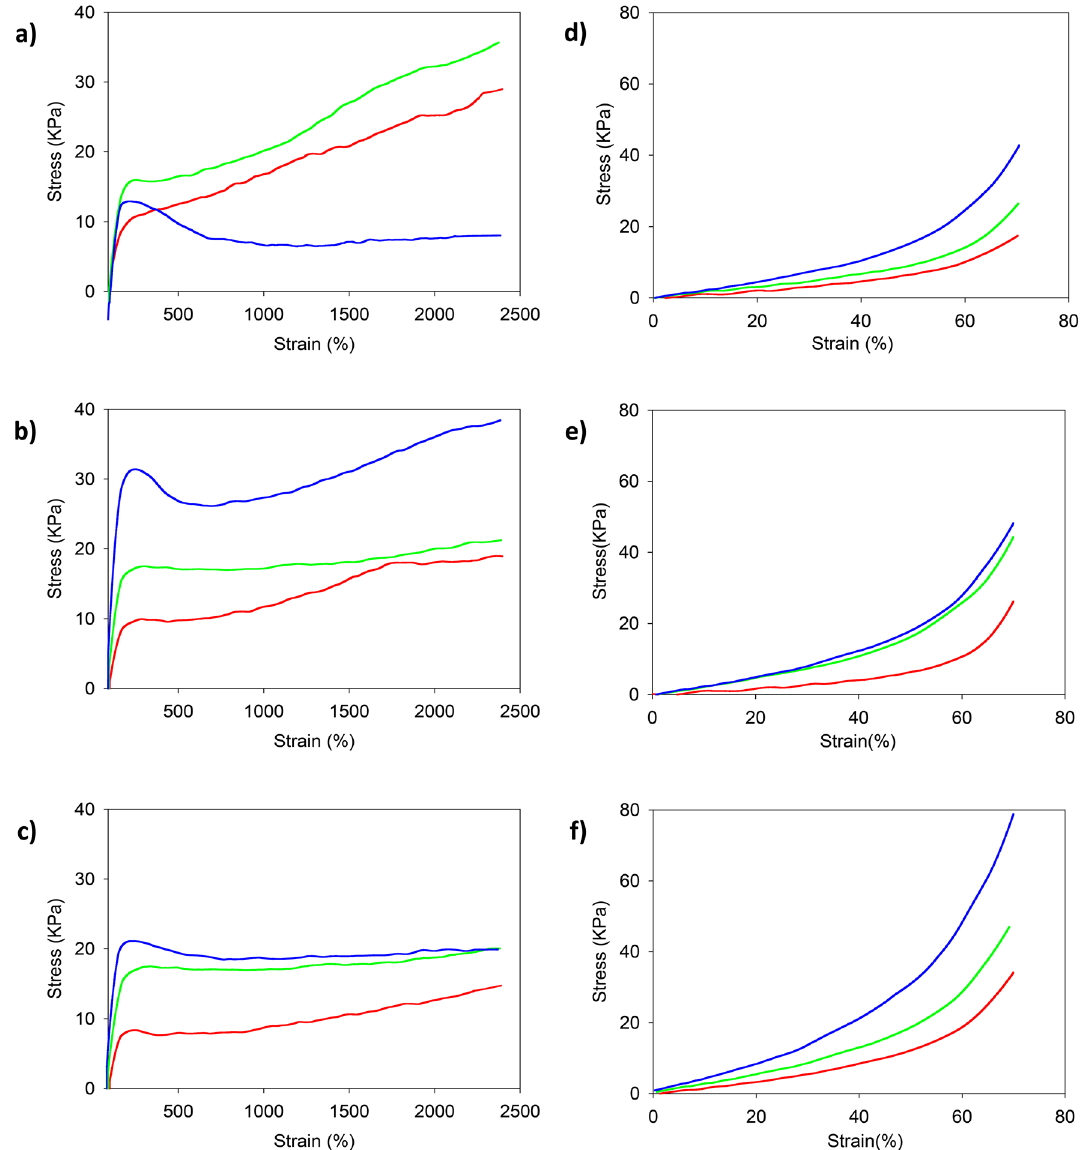
Figure 6. Tensile strength test results of PAAm-MSiO 2 hydrogels prepared by 117.5 nm ( a ), 216.5 nm ( b ), and 311.5 nm ( c ) MSiO 2 cross-linker and compressive strength test results of PAAm-MSiO 2 hydrogels prepared by 117.5 nm ( d ), 216.5 nm ( e ), and 311.5 nm ( f ) MSiO 2 cross-linker. In the graph, red line, green line, and blue line